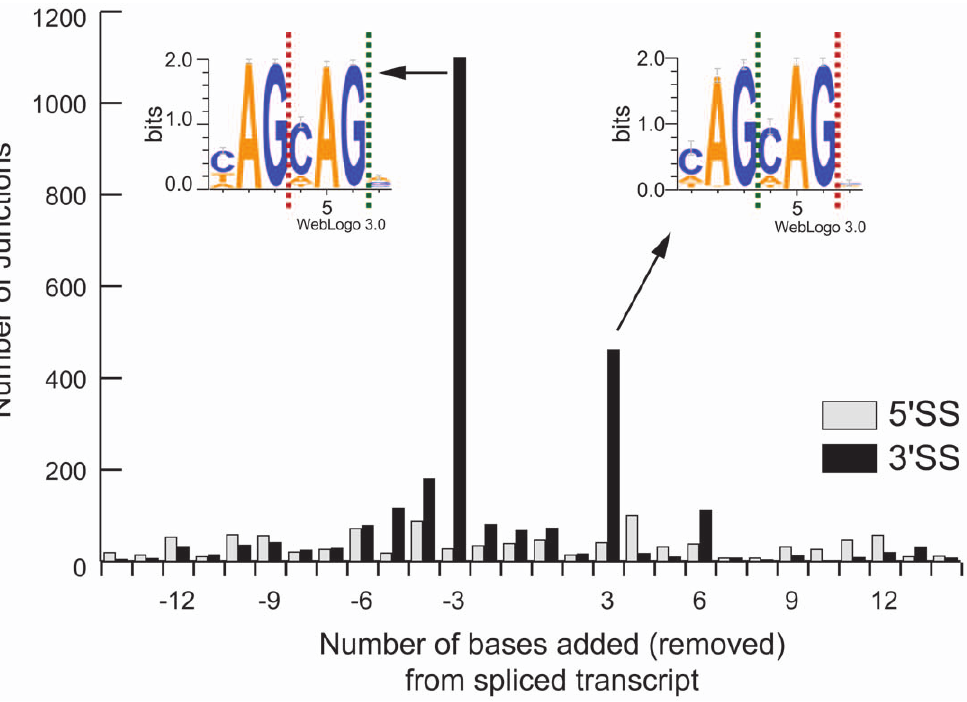
Figure 6. Alternative 5 9 and 3 9 splice sites. HMMSplicer results within 15 bp of RefSeq introns were analyzed to measure the number of bases added or removed from the spliced transcript. There were 997 instances where the intron had an alternate 5 9 splice site (5 9 SS, shown in grey) and 2,577 instances of an alternate 3 9 splice site (3 9 SS site, shown in black). The most common alternative splice was 3 bases removed or added to the exon at the 3 9 SS. TopHat results showed a similar pattern, though only 875 alternates (262 5 9 SS alternates and 613 3 9 SS alternates) are found, less than a quarter of the HMMSplicer results. WebLogos were constructed from the sequences at the 1,099 alternate 3 9 SS with three bases removed from the transcript and the 460 alternate 3 9 SS with three bases added to the transcript. For these, the green dashed line shows the alternate splice site while the red dashed line shows the canonical splice site. In both cases, a repetition of the YAG splice motif is evident.